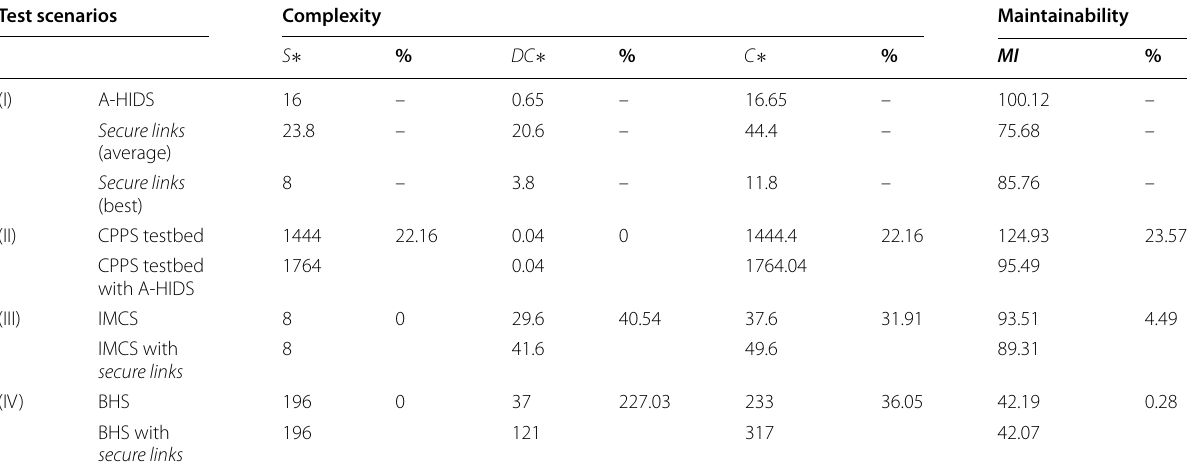
Table 3 Evaluation methodology results using FB pipeline measures Test